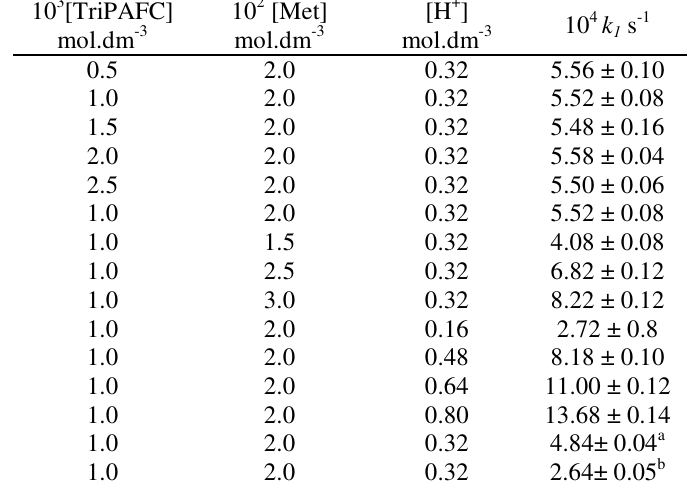
Table 1. Effect of varying the concentration of [Met], [TriPAFC] and [H + ] on the rate